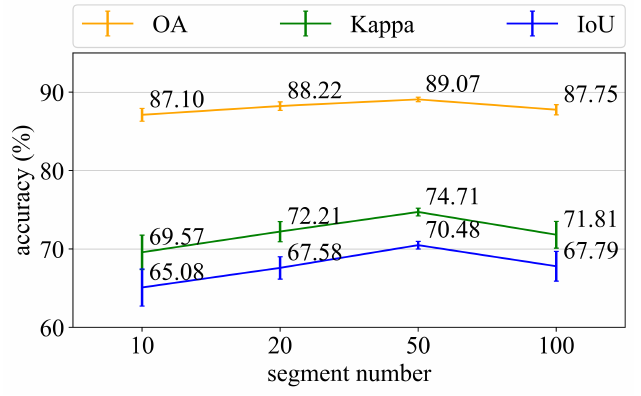
Figure 12. Quantitative comparison of CHeGCN at different segmentation